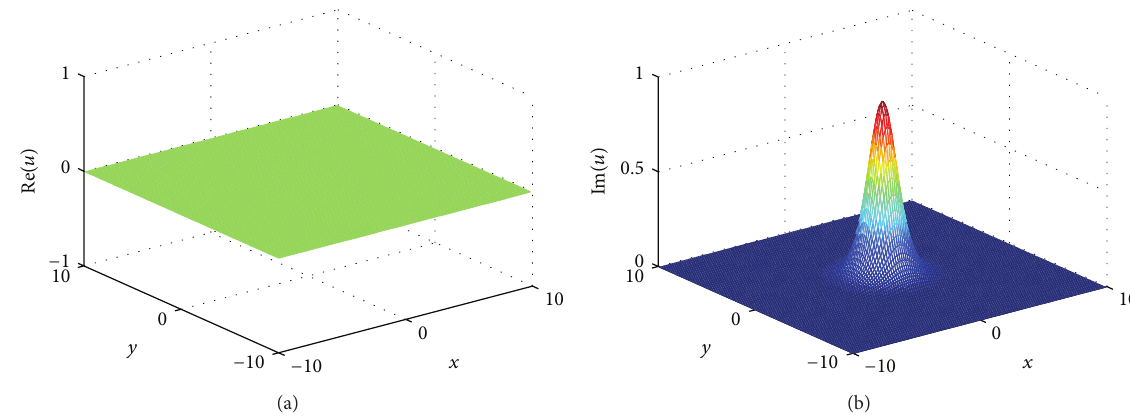
Figure 12: Lattice soliton profile corresponding to the second renormalization factor on the Penrose potential, with 𝑉 0 = 3.5 , 𝐾 = 1 , and 𝜇 = 1.5 for the self-focusing quintic model. (a) Real part of the lattice soliton. (b) Imaginary part of the lattice soliton.